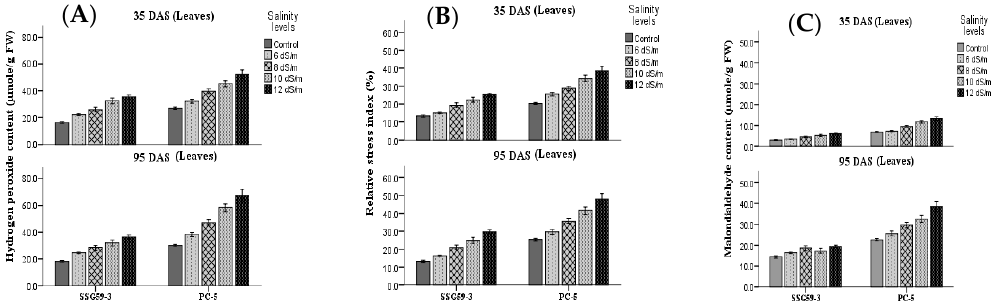
Figure 9. Effect of salt stress on hydrogen peroxide (H 2 O 2 , A ), relatives stress index (RSI, B ), and malondialdehyde (MDA, C ) of sorghum genotypes at 35 and 95 DAS. All values are the means ± SD of three biological replicates. Asterisks represent significant (*) and highly significant (**) differences among different treatments.